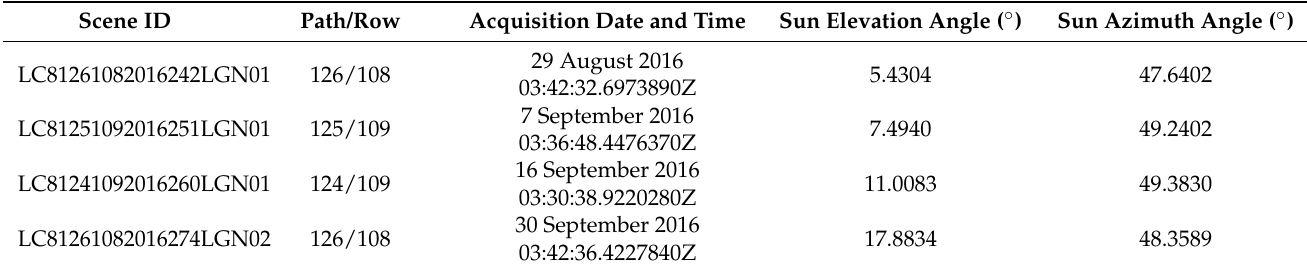
Table 1. Landsat-8 images used in this